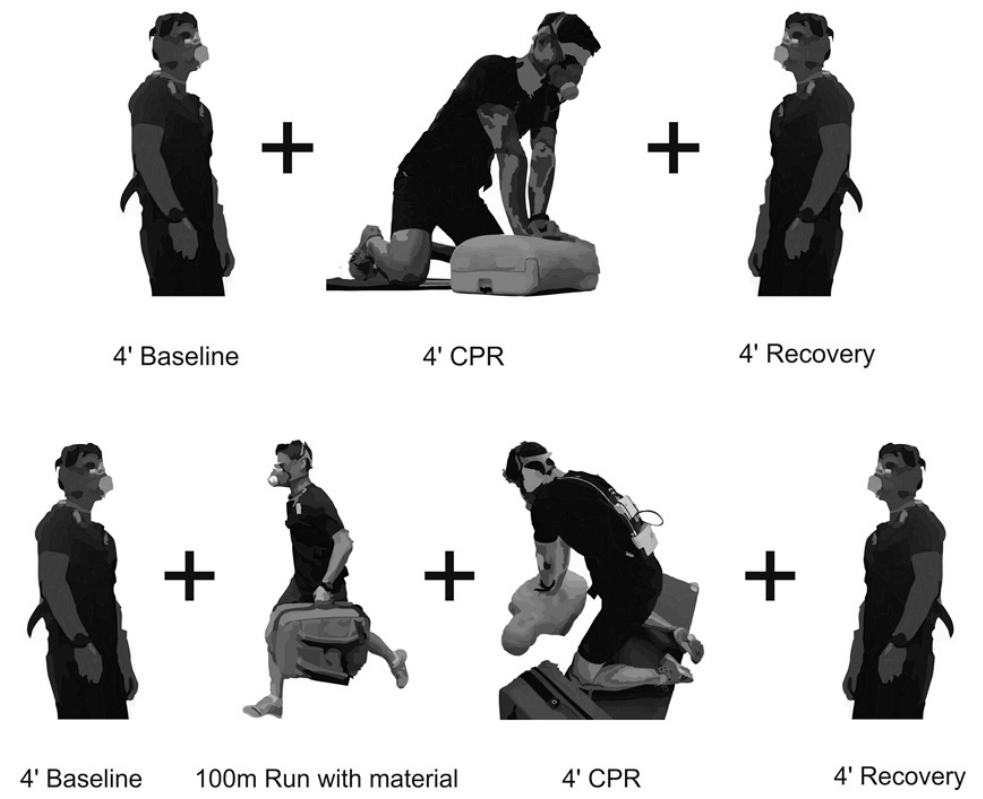
Figure 1. Testing protocols: (i) 4-min baseline + 4-min cardiopulmonary resuscitation (CPR) + 4-min recovery (upper panel) and (ii) 4-min baseline + 100-m Run with the material + 4-min CPR + 4-min recovery (lower panel). The manikin used is in accordance with the American Heart Association (AHA) and European Resuscitation Council (ERC) guidelines for CPR practice.